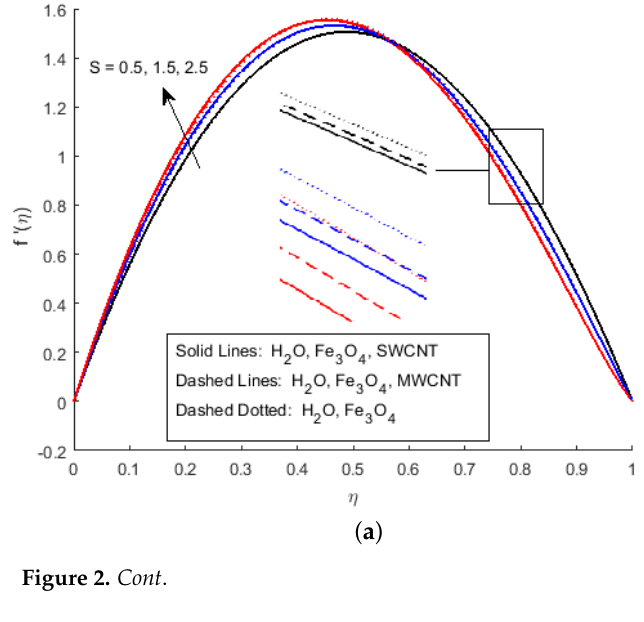
Table 8. The heat transfer has been calculated percent wise as for the various nanoparticles Pr = 6.2, S = 1.5, Ec = 0.4, using the percentage formula %increase = With Nanoparticle 100 = %enhancement. Φ Φ 1 ,